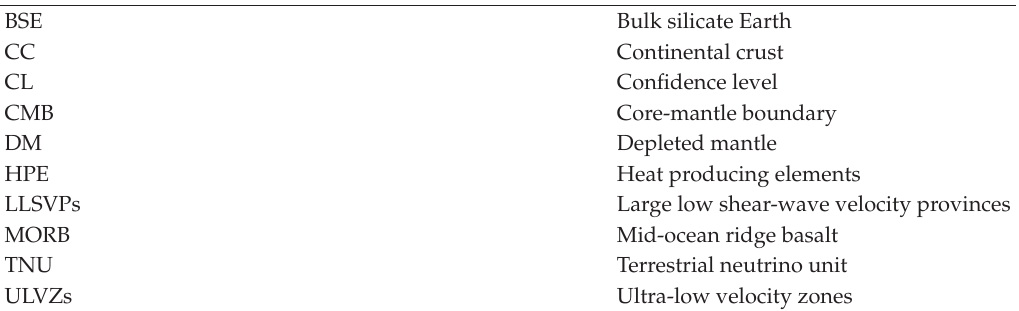
Table 1: Terminology used in the